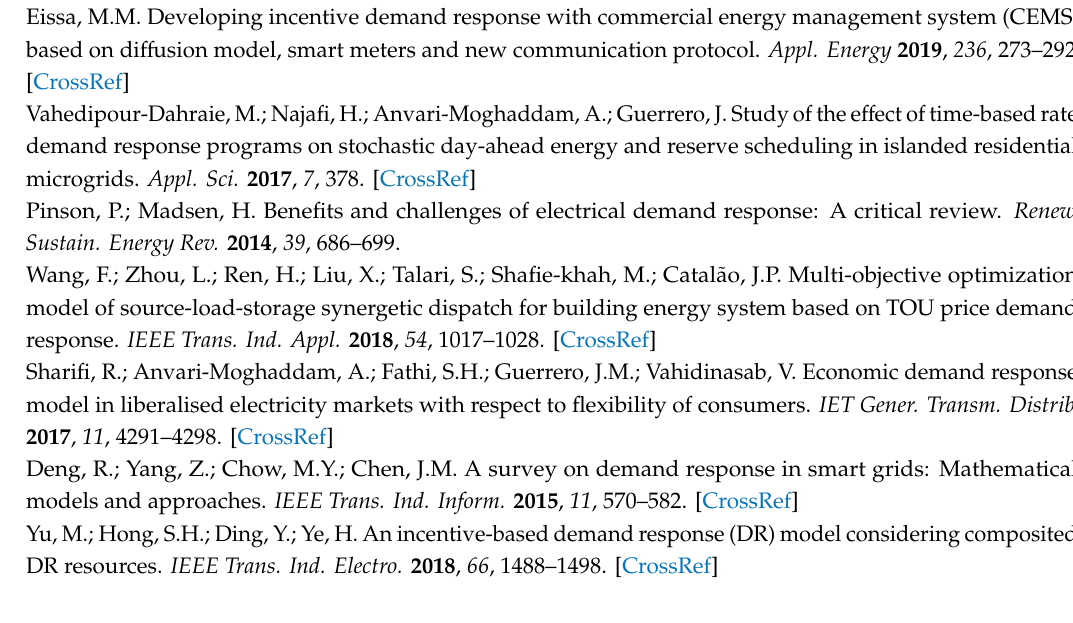
Figure A2. Real-time electricity price curve.